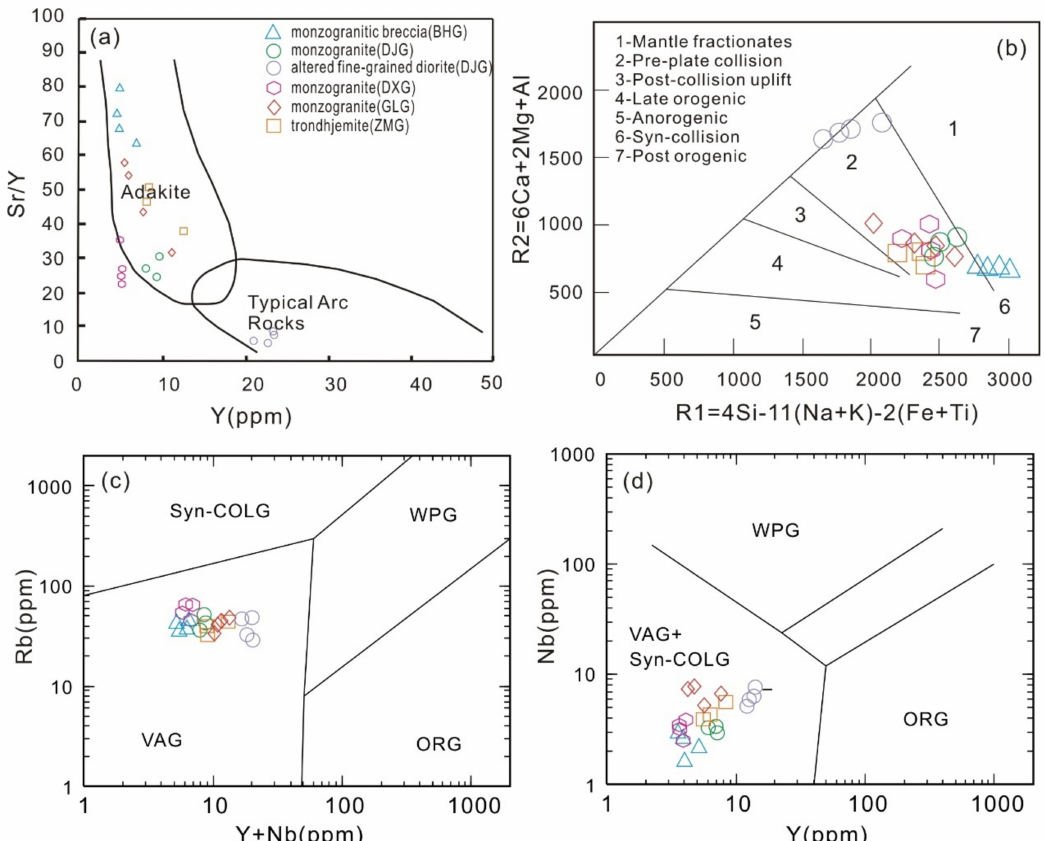
Figure 9. ( a ) Sr/Y-Y diagrams for the dioritic gneisses adapted from Martin (1999) [61]; ( b ) R1 vs. R2 diagram (after Batchelor et al., 1985; Qu et al., 2004) [62,63], R1 = 4Si − 11(Na + K) − 2(Fe + Ti) (mol), R2 = 6Ca + 2 Mg + Al (mol); Discrimination diagrams for granitic rocks after Pearce et al. (1984) [64], ( c ) Rb-Y + Nb diagram and ( d ) Nb-Y diagram. VAG: volcanic-arc granites; syn-COLG: syn-collisional granites; WPG: within plate granites; ORG: ocean-ridge